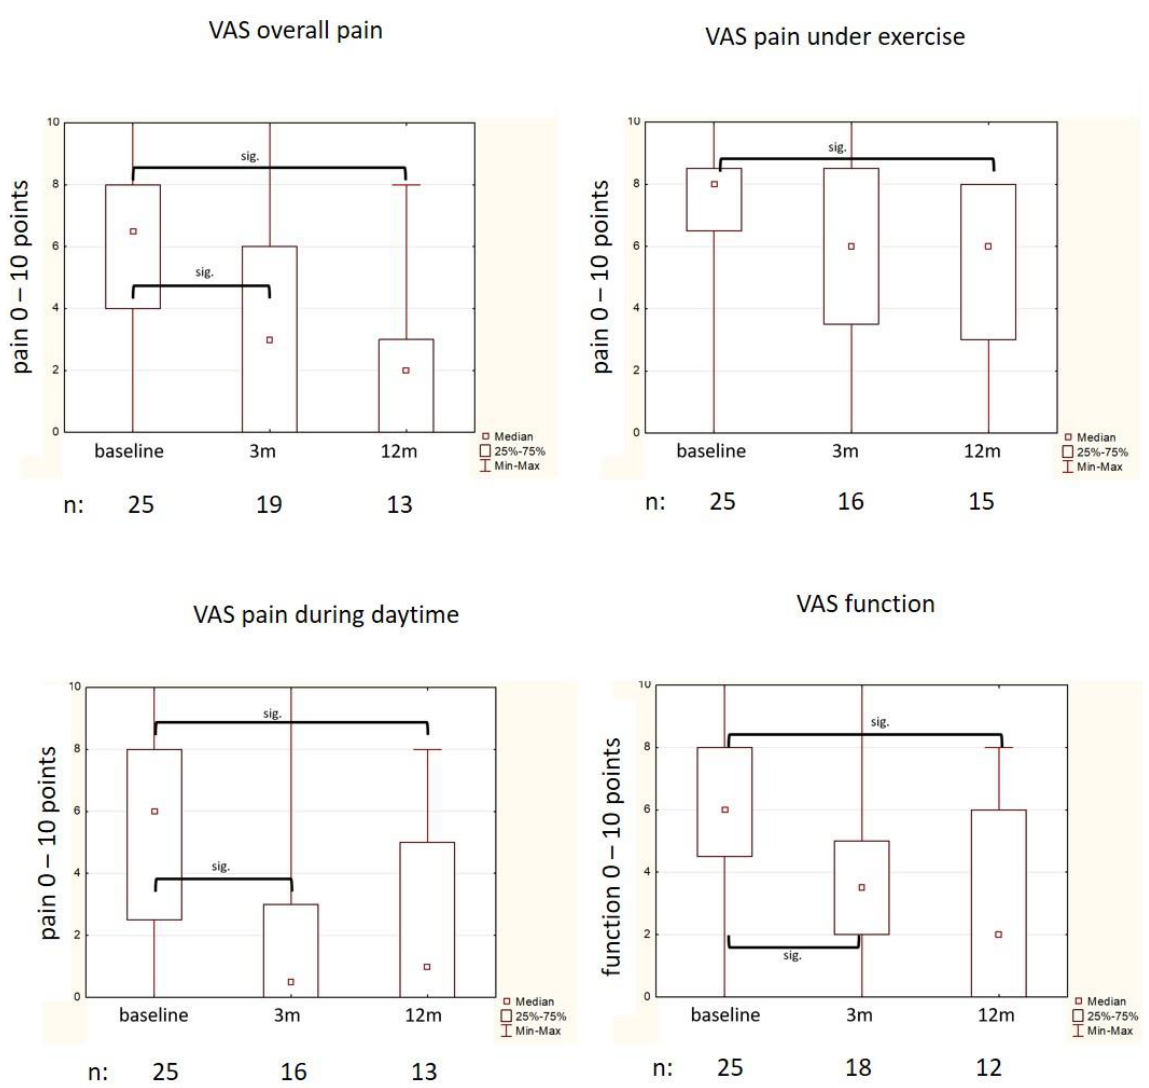
Figure 1. VAS values before LD-EBRT (baseline) and after 3 mo and 12 mo after LD-EBRT (median, IQR, min/max).